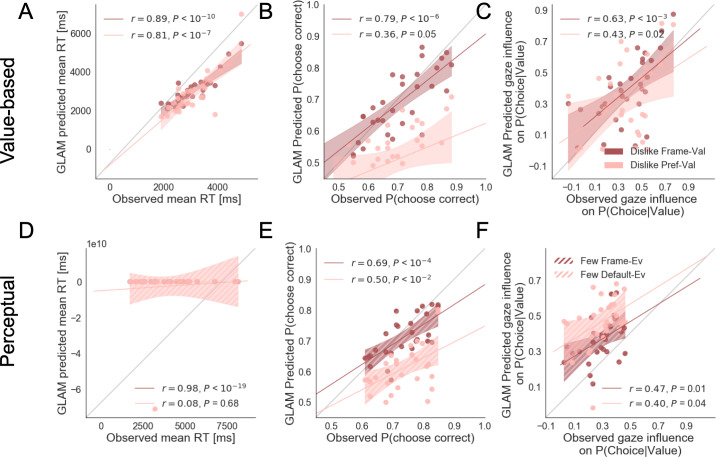
Individual out-of-sample prediction from the GLAM model for behavioural measures in Value (dislike) (A–C) and Perceptual (fewest) Experiments (D–F).In the dislike frame, two models are used to generate simulations: preference-value, value reported in the BDM bid was used directly to fit GLAM model; and frame-value, the values were adjusted to comply with the frame modification. The model predicts participants mean reaction time (RT) (A), probability of choosing the best item (i.e. item with lower value) (B) and the influence of gaze in choice probability (C, check Results section for more details on gaze influence measure). The frame-value model correlates better with the observed data. In the Perceptual Experiment, fewest frame, also two possible models are used to generate simulations: default-evidence, the number of dots was used directly to fit the data, and frame-evidence, the evidence was adjusted to comply with the context modification (i.e. opposite of the number of dots). We show the correlation between the data and simulations for RT (D), the probability of choosing the best alternative (i.e. alternative with fewer dots) (E) and gaze influence (F). In this case, frame-evidence model also predicts the behaviour in the fewest frame better. The results corresponding to the models using frame-evidence are presented in red and the models using default-evidence in pink. Dots depict the average of predicted and observed measures for each participant. Lines depict the slope of the correlation between observations and the predictions. The shadowed region presents the 95% confidence intervals, with full colour representing Value Experiment and striped colour the Perceptual Experiment. Model predictions are simulated using parameters estimated from individual fits for even-numbered trials.